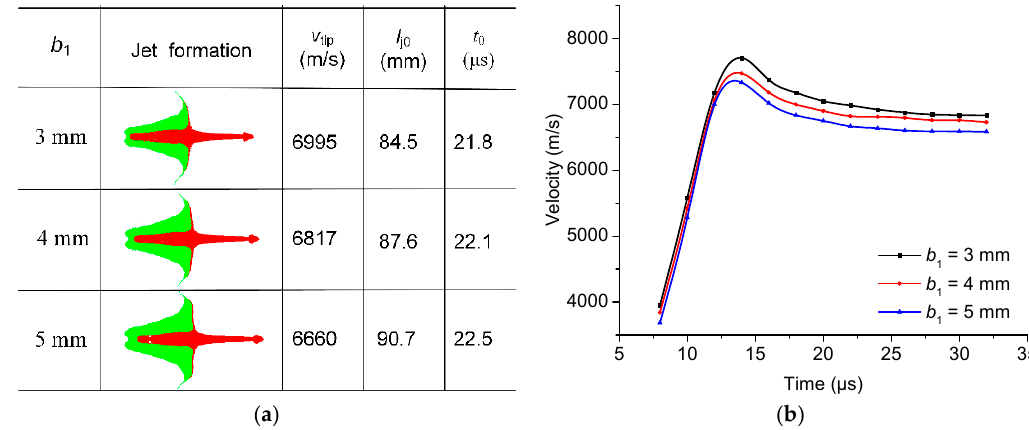
Figure 10. For different reactive liner thicknesses: ( a ) RM-CJ formation characteristics at standoff of 1.0 CD; ( b ) RM-CJ tip-velocity to time curves.